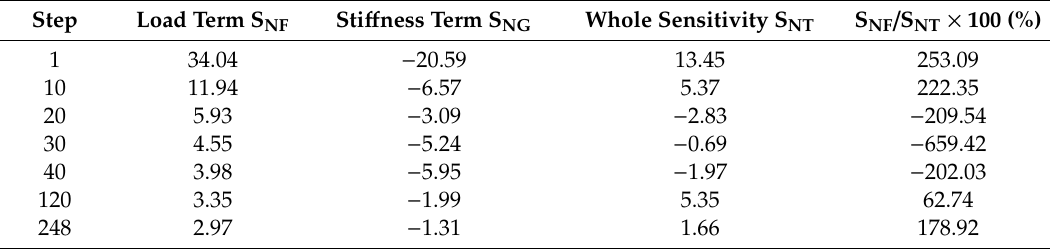
Table 2. Node 51’s strain energy sensitivity values for partial evolution